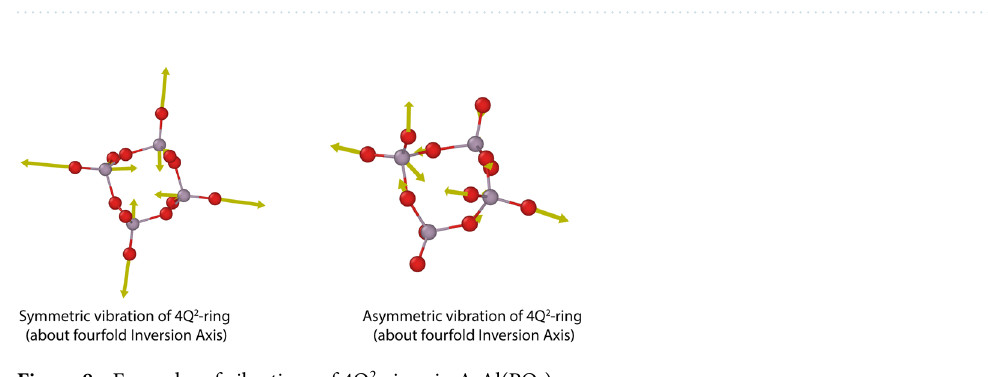
Table 3. The calculated Raman and IR active modes of A-Al(PO 3 ) 3 (more details in the supplementary materials Table S1.3). r—frequency assigned to the 4Q 2 ring, s—the strongest in range.